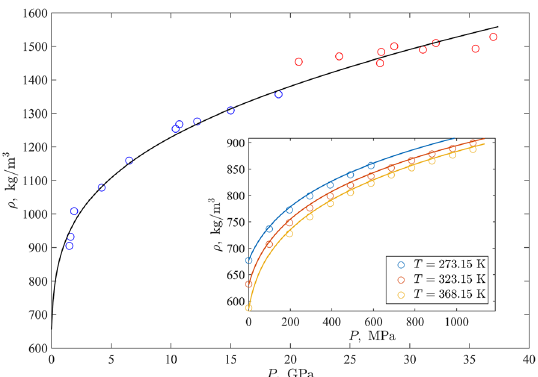
Figure 3. An examples of a density isotherms T = 298.15 K for n-hexane obtained via the shock wave compression 33 . Circles marking experimental values are coloured as blue for P < 20 GPa and red for P > 20 GPa ; between this pressures, an existence of the density jump related to a structure transition was argued in 33 . The solid line represents the model prediction based on the the half-sum of Tait’s and Murnagnan’s equations. Inset: Bridgman’s data 29 for n-hexan’s isotherms T = 273.15 K , T = 323.15 K , and T = 368.15 K (circles) and the predicted isotherms shown as solid curves of the corresponding